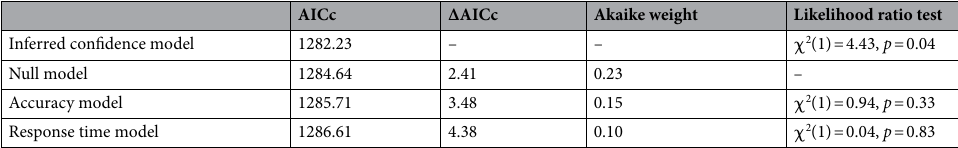
Table 1. For the different models described in the text, the table indicates the AIC corrected for small samples (AICc) and where applicable the difference in AICc compared to the inferred confidence model (ΔAICc), the Akaike weight against the inferred confidence model and the likelihood ratio test relative to the null model. In the inferred confidence model, prioritization choices are predicted from the difference in average inferred confidence between both sets. In the accuracy model, the predictor is the difference in accuracy between both sets. In the response time model, the predictor is the difference in median response time between both sets. All models also included participant ID as a random